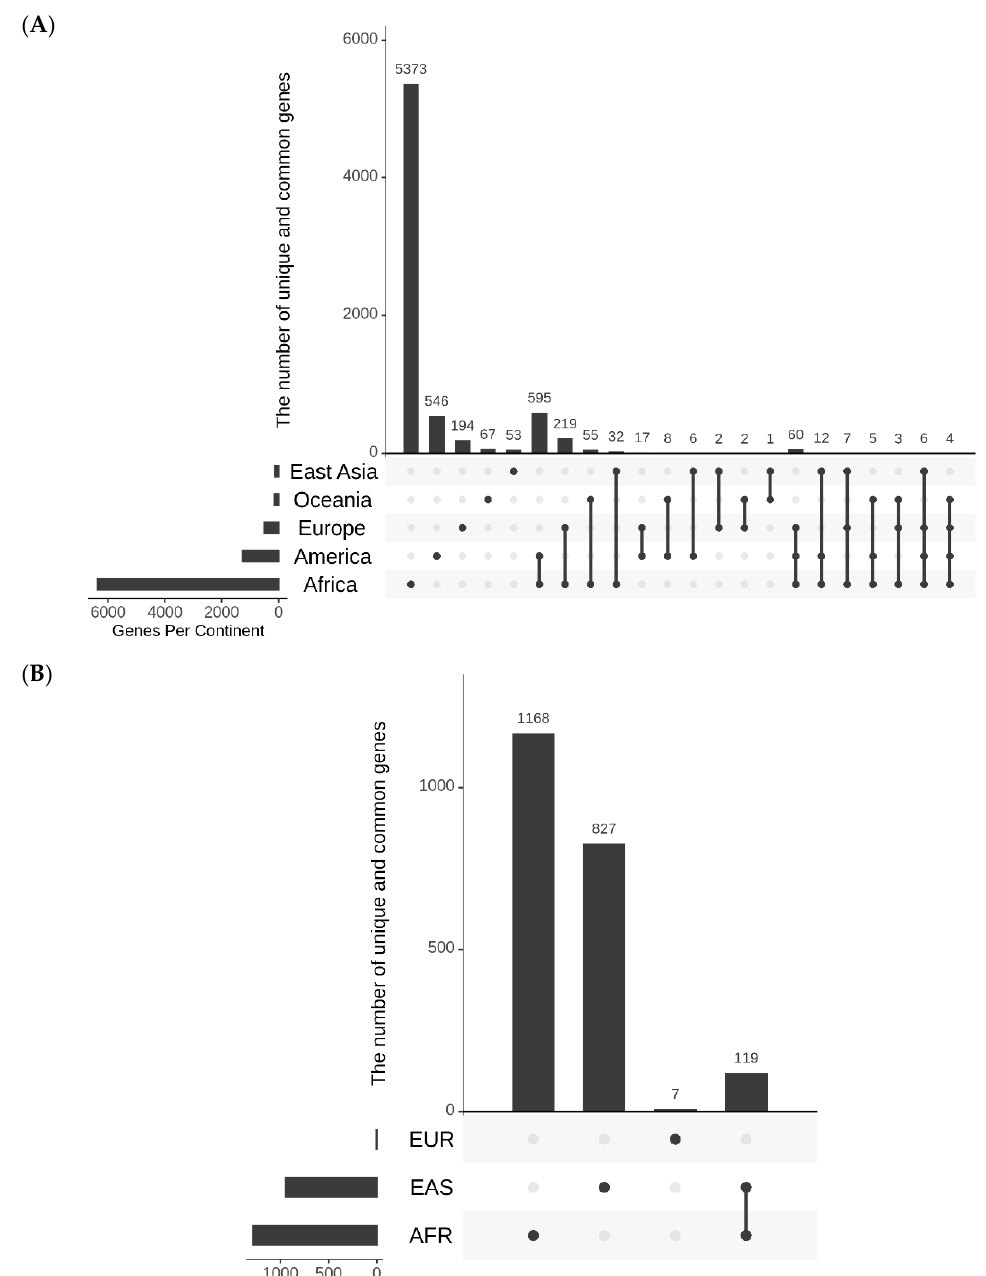
Figure 4. UpSet diagrams showing the number and nature intersections of gene lists for ARSA ( A ) and RACA ( B ). Vertical bars show the number of genes resulting from the intersections between gene lists. Horizontal bars depict the total number of genes in each continental group. The nature of intersections is shown with gray and black dots. A black dot means the presence of the gene in the corresponding continental group, while a gray dot means the absence of the gene in corresponding group. Black dots connected by lines indicate the continental groups involved in the interaction. For example, one black dot and four gray ones correspond to the vertical bar that shows the number of genes present in one continental group and absent in all other